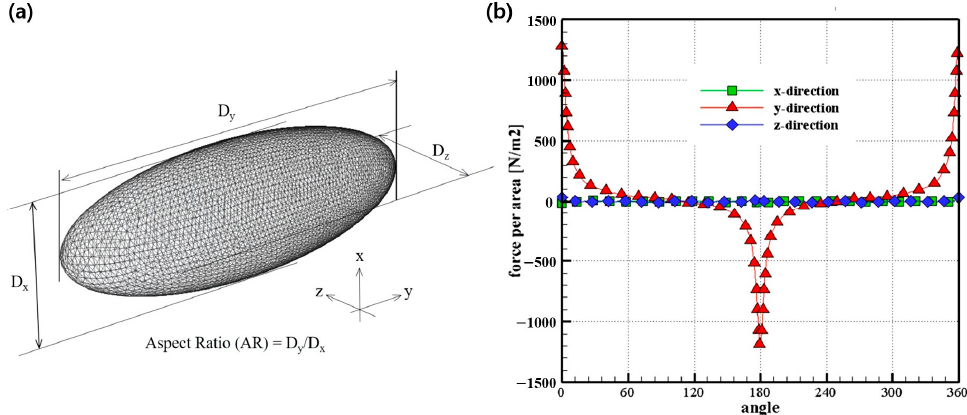
Figure 5. ( a ) The shape of the ellipsoid with aspect ratio. ( b ) Force per area on ellipsoidal particle surface for various angles.